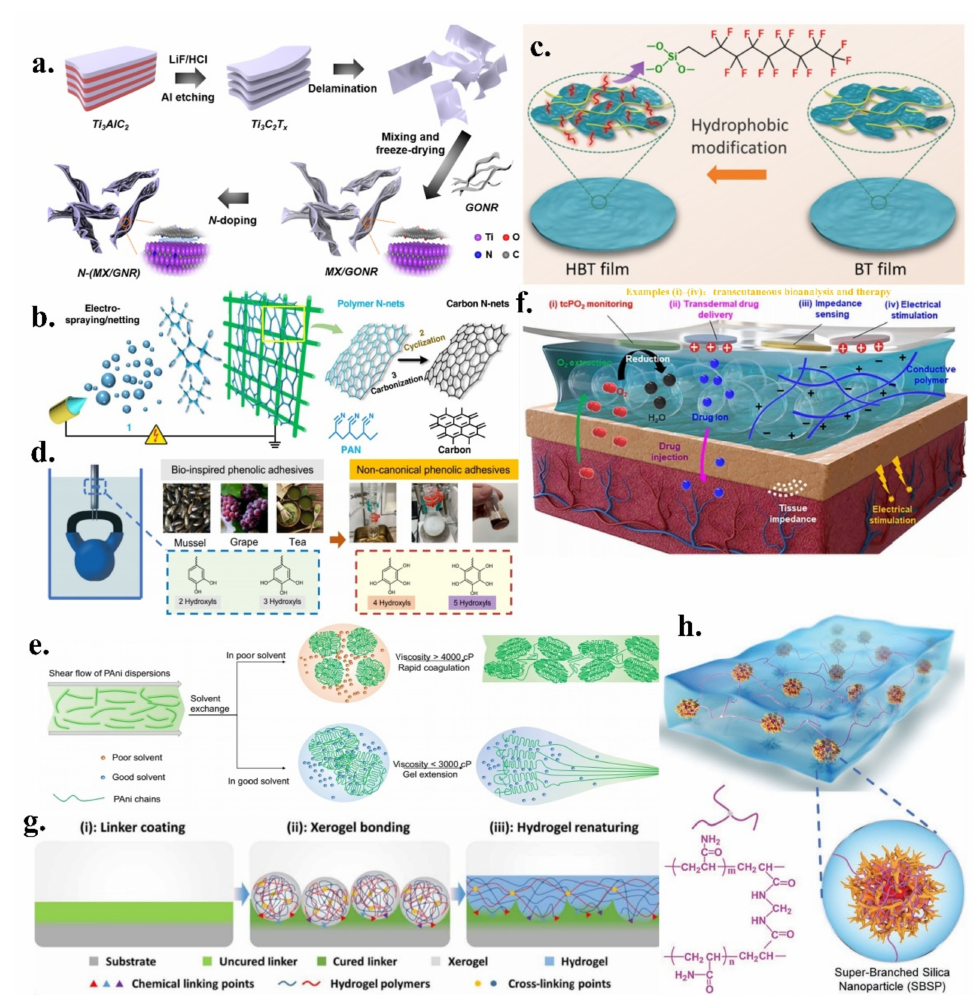
Figure 2. ( a ) New dopant-induced hybridisation method for 1D/2D materials; reproduced